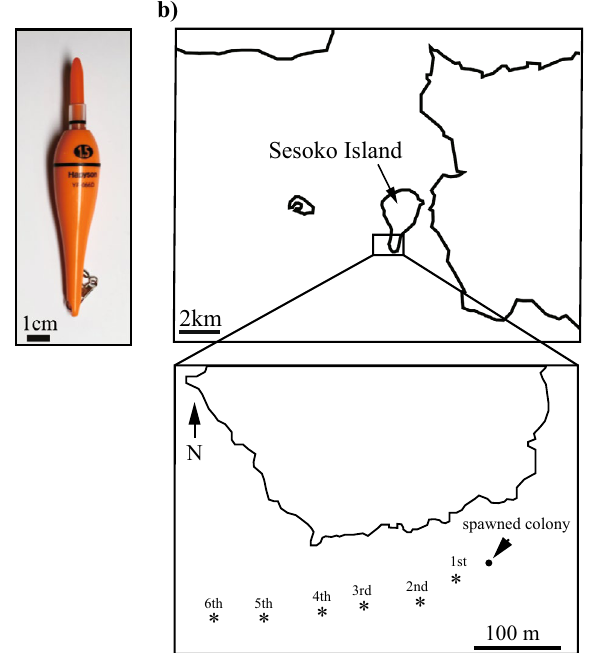
Figure 1. Map of study site. ( a ) Floats used in this study had fluorescent light bars (ϕ 13.0 × 122 mm, Hapyson) attached. ( b ) Trajectory of the float measured in the daytime via GPS. The dot indicates the location of the spawning colony where the float was released. Asterisks indicate the location of water sampling at 9 min